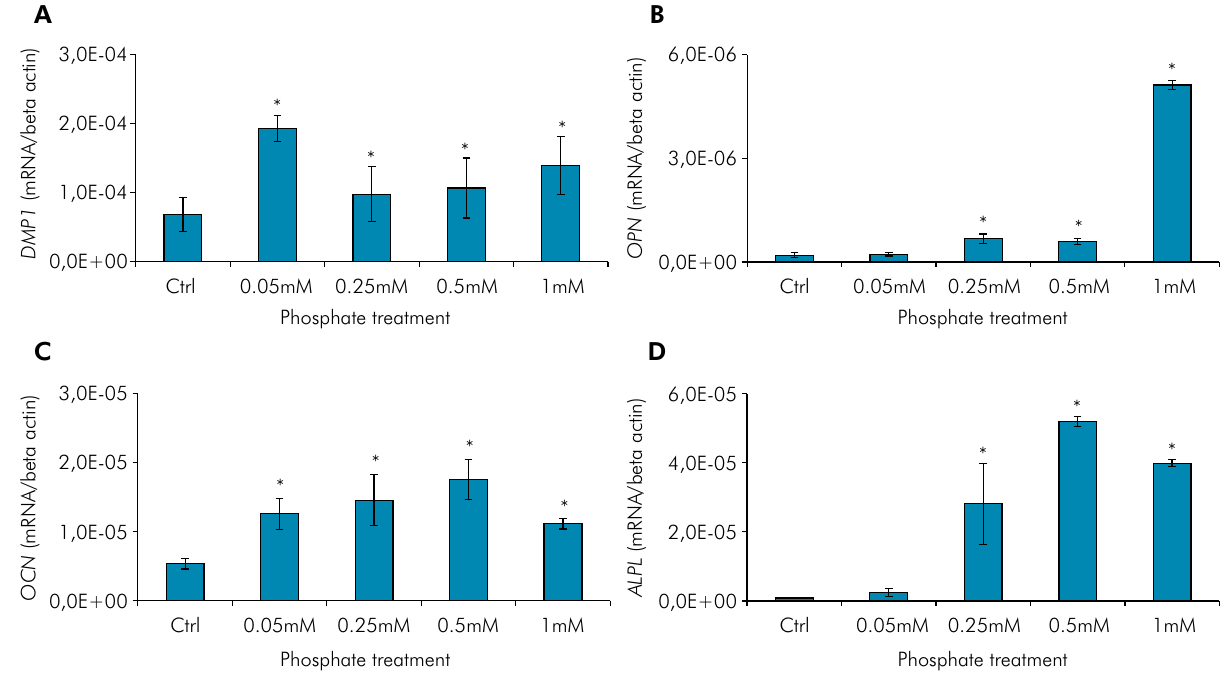
Figure 5. Effect of inorganic phosphate treatment (Pi) on the expression of DMP1 , ALPL , OPN , and OCN at 3 days after treatment (Pi-treated). *Statistically different from the control group by one-way ANOVA followed by the Bonferroni test (alpha = 0.05).